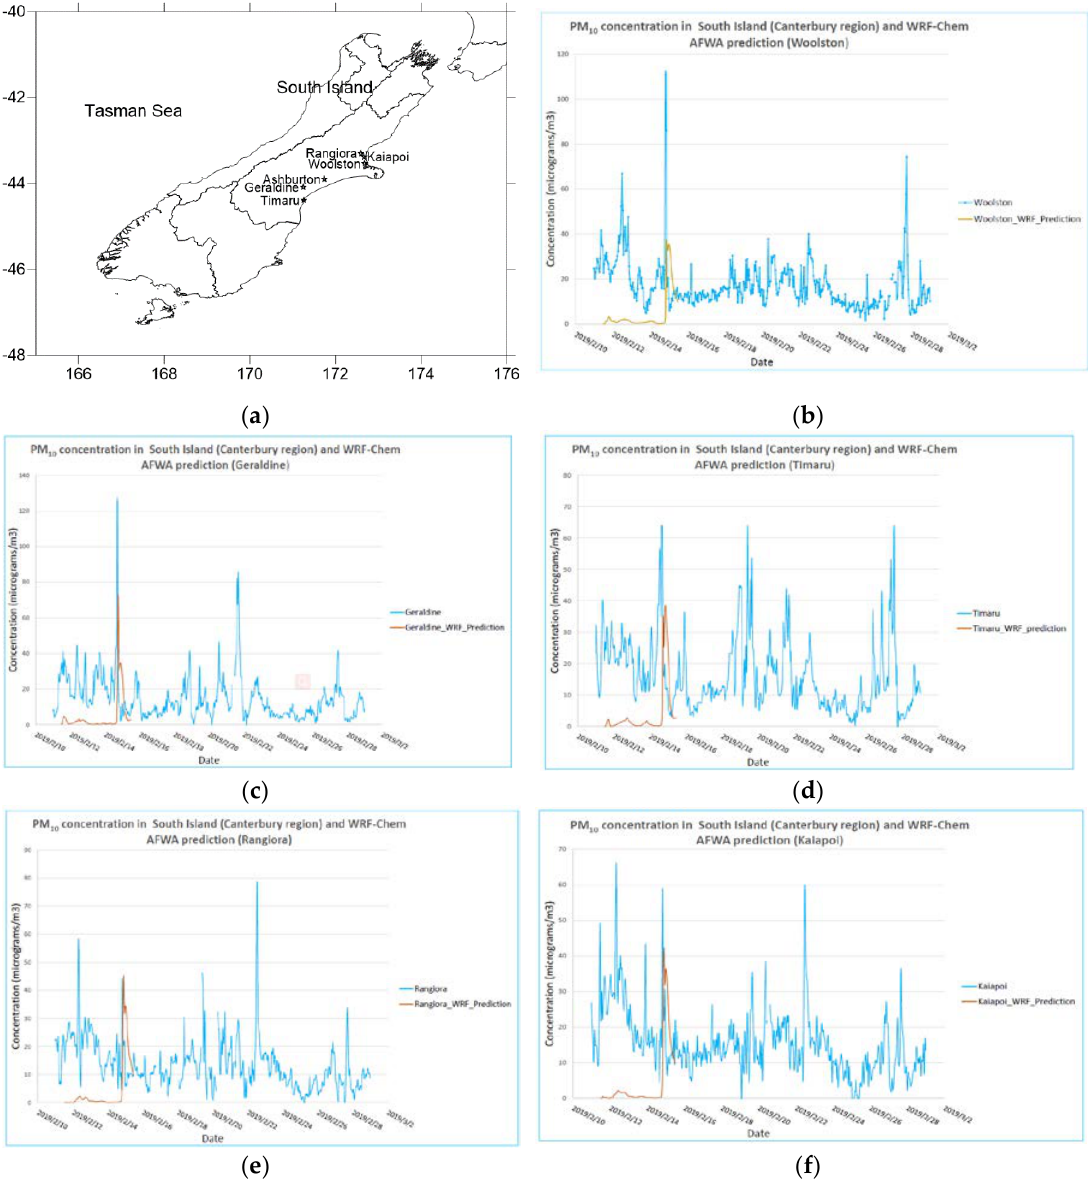
Figure 10. ( a ) Monitoring stations in the Canterbury area of the South Island, New Zealand, for 14 February 2019. ( b – f ) Predicted PM 10 from WRF-Chem with AFWA dust scheme (red line), FINN fire emission and MOZART and GOCART chemistry mechanism and observed PM 10 (blue line) at Woolston, Geraldine, Timaru, Rangiora and Kaiapoi.